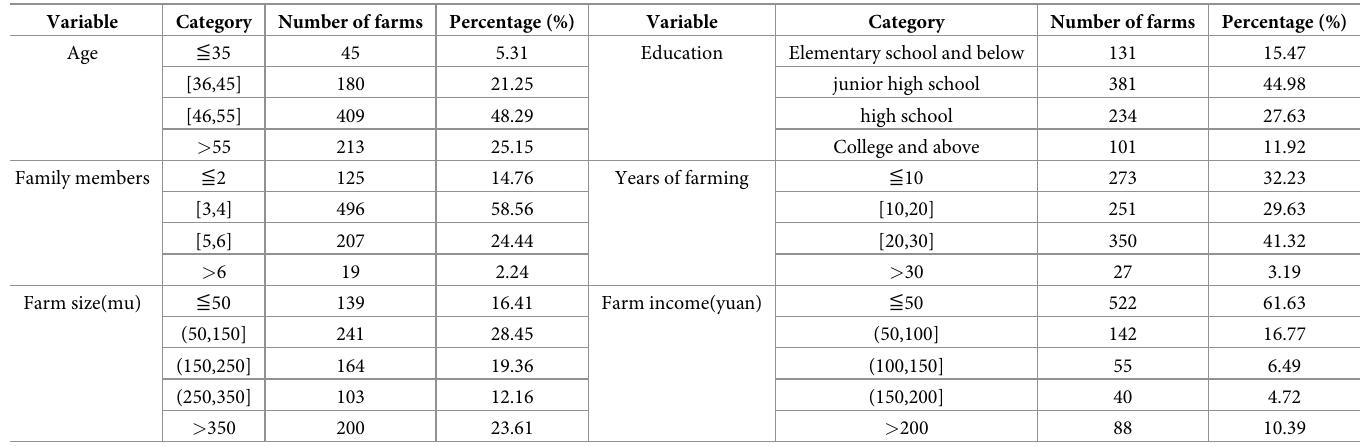
Table 1. Basic characteristics of the sample family